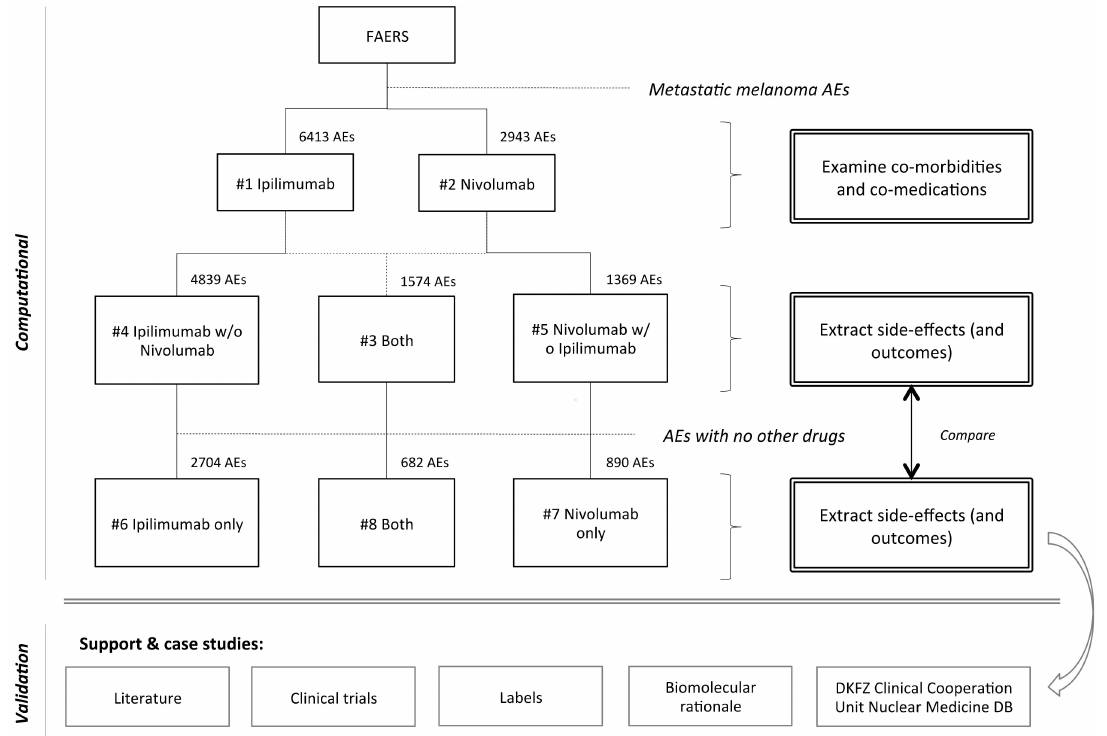
Figure 1. Overview of the side effect profiling approach. Metastatic melanoma patient cohorts treated with ipilimumab and/or nivolumab were identified and a virtual trial was performed, in which we compared reaction occurrence in each set of AEs. First we profiled the reported AEs in patient cohorts receiving only ipilimumab and/or nivolumab (cohorts #6–#8). These safety profiles were similar